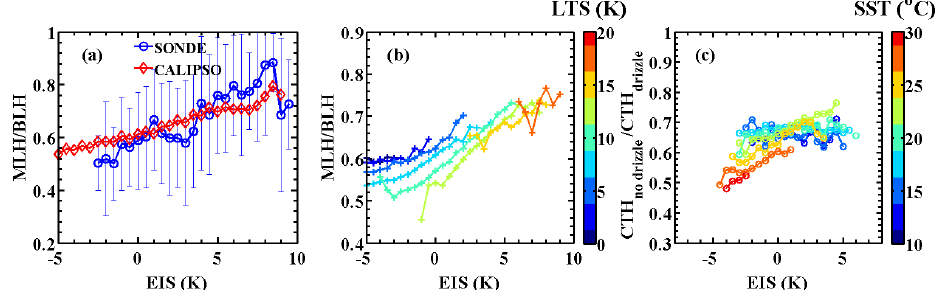
Figure 6. (a) Relationship with EIS and MLH / BLH in MAGIC and satellite observations over extended MAGIC region; (b) relationship between EIS and CALIOP-derived MLH / BLH under different LTS over the global oceans; (c) seasonal mean relationship between EIS with CTH nodrizzle / CTH drizzle under different SST over the global oceans. The standard deviations (not shown in panels b and c ) for data in the panels (a) and (b) are ∼ 0.2, and ∼ 0.1 in (c)